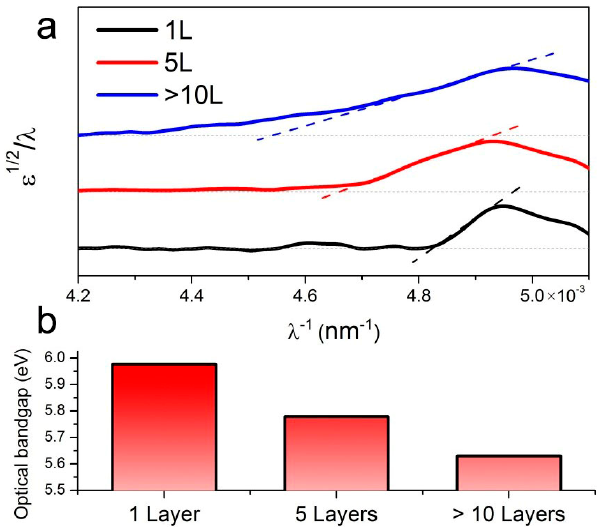
Figure 6. Ultraviolet-visible adsorption spectra of h-BN films of various thicknesses taken at room temperature. ( a ) UV adsorption spectra of 1 L, 5 L and thick (>10 L) h-BN films ( ε 1/2 / λ versus 1/ λ ); ( b ) Calculated optical bandgap for each h-BN film.